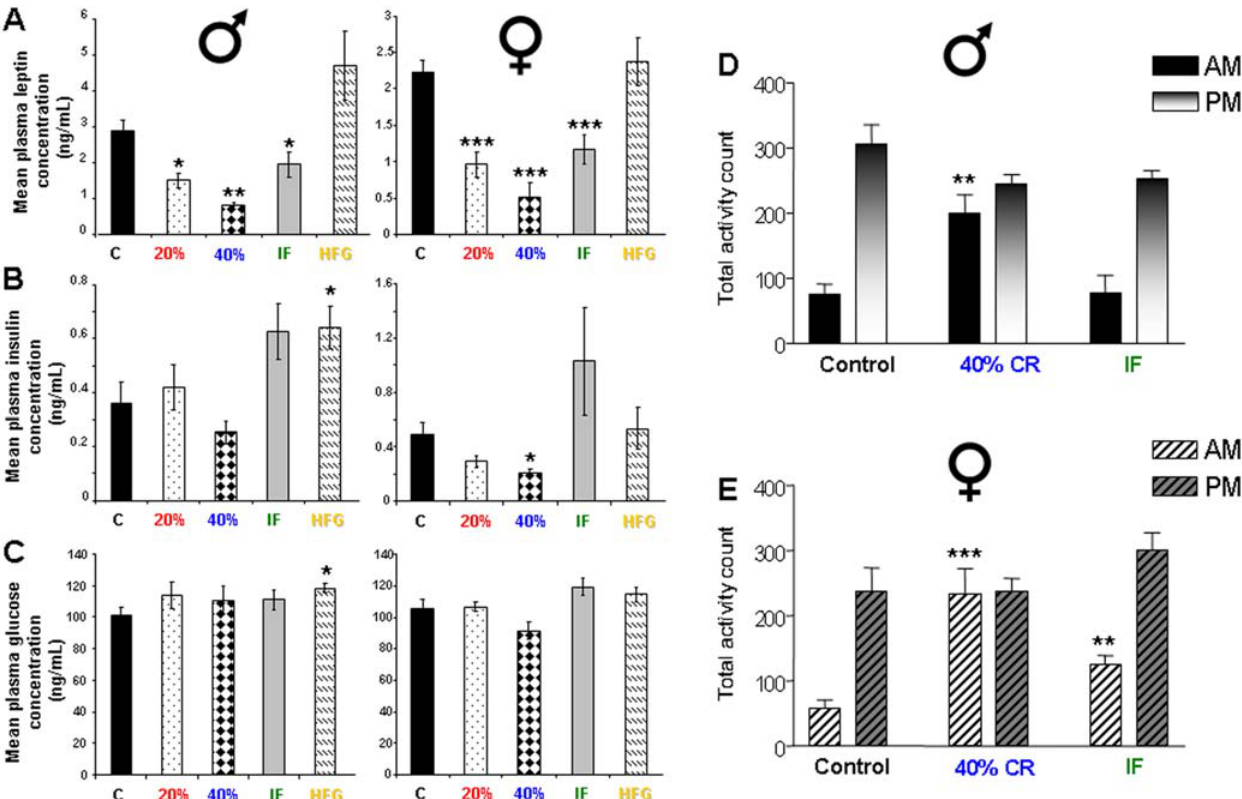
Figure 3. Dietary manipulated male and female rats respond similarly with respect to appetite control, glycemia, and activity. Plasma levels of leptin (A) , insulin (B) , and glucose (C) were measured in male and female rats at the 4 month on-diet time point. Figures (D) and (E) show the day and night-time activity levels of male and female rats maintained on control, 40% CR, and IF diets. *p , 0.05, **p , 0.01, ***p , 0.001.